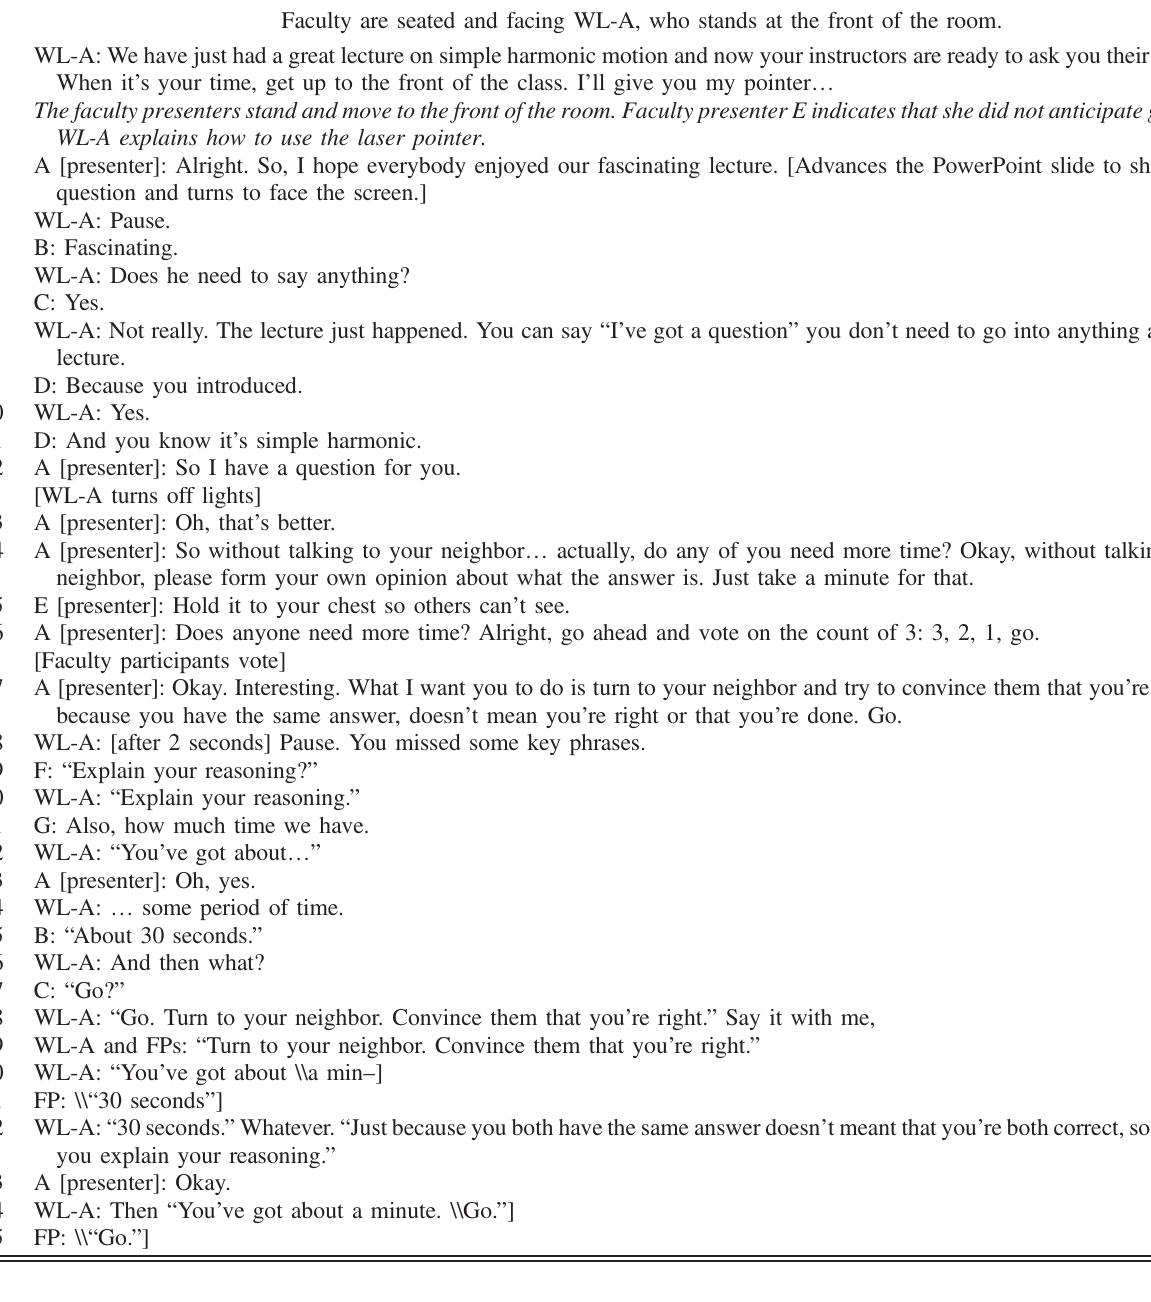
TABLE III. Transcript of the first group of presenters being paused and critiqued in Session A. When faculty and WL-A offer scripted words and phrases as suggestions or critiques, these words and phrases are indicated by quotation marks. When these line numbers are referenced in the main text, they are prefaced with an “ A.